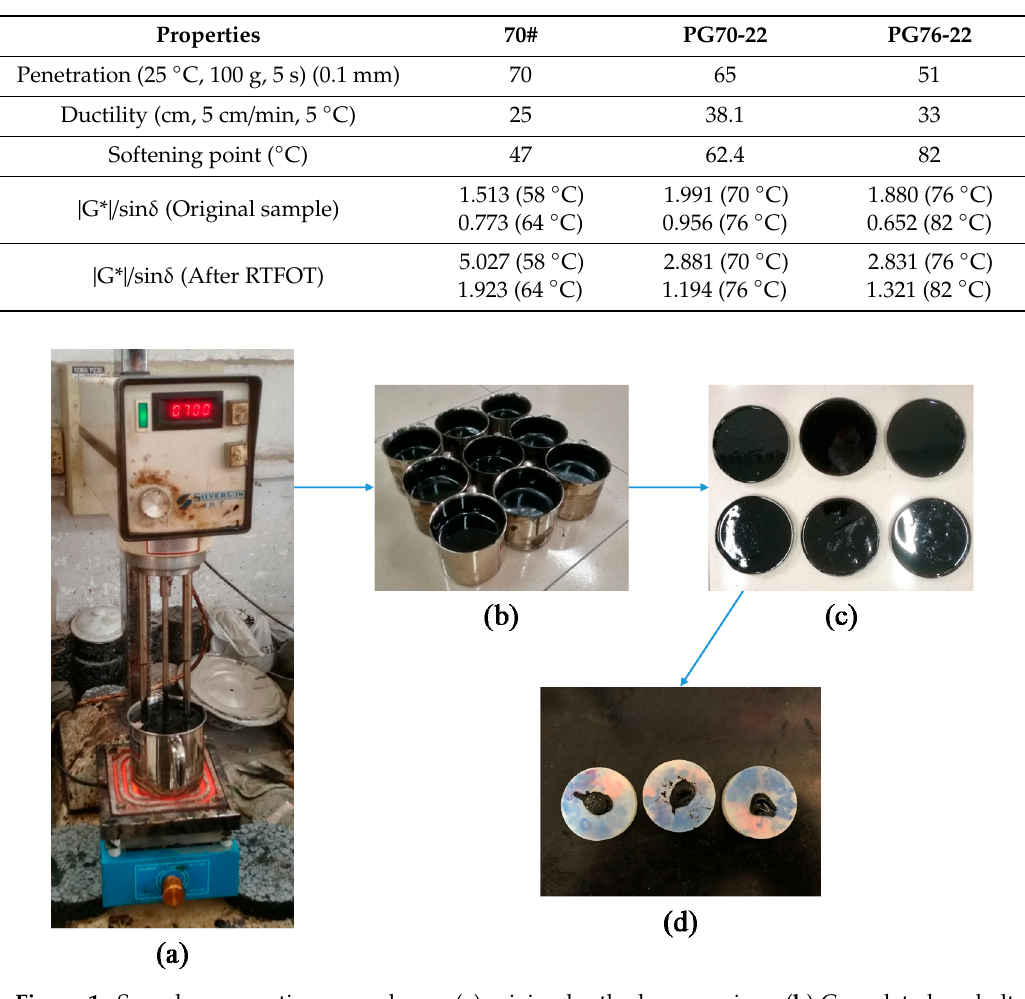
Figure 1. Sample preparation procedures: ( a ) mixing by the homogenizer; ( b ) Completed asphalt mastics; ( c ) Mastic plates after oven aging; ( d ) Samples out of the silicon mold.